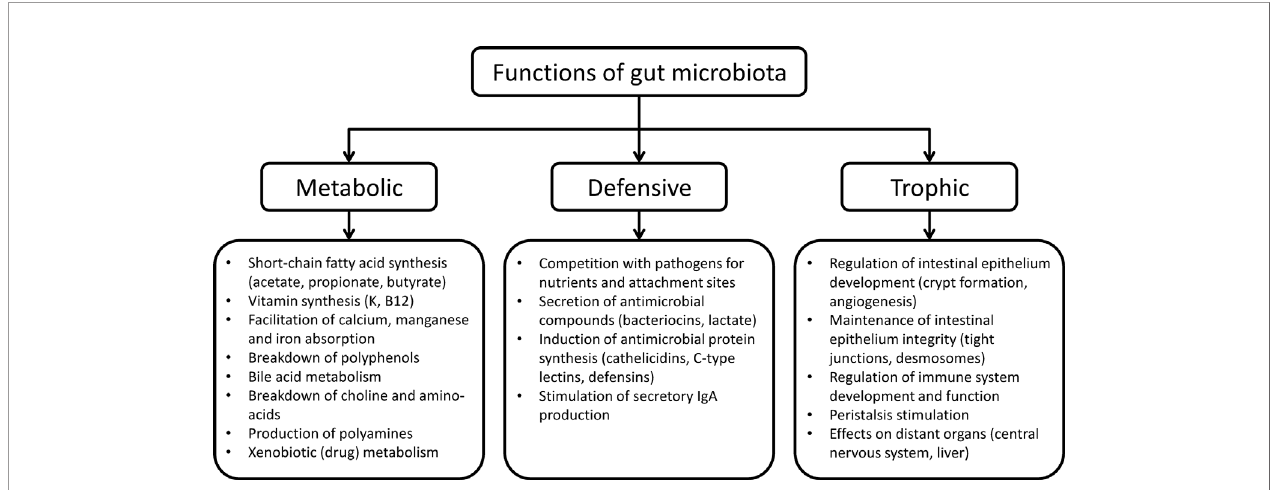
FIGURE 1 | Functions of human gut